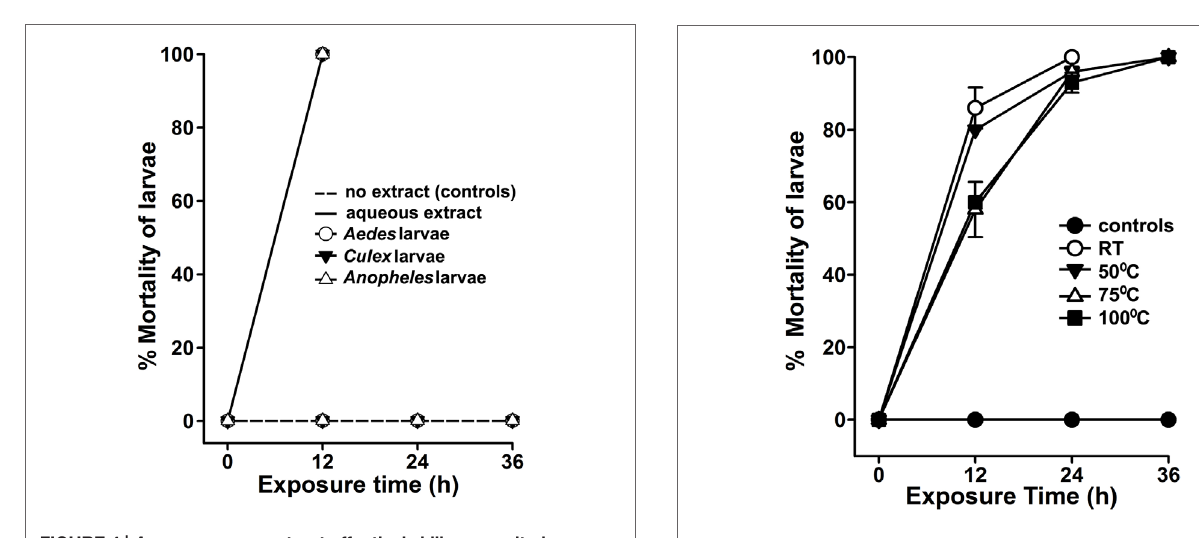
FigUre 4 | Agave aqueous extract effectively kills mosquito larvae. A. aegypti , C. quinquefasciatus, or A. stephensi larvae were sham treated (no extract, controls) or exposed to 100 μ g/ml aqueous extract of Agave angustifolia . The percentage mortality of larvae at each time point was calculated against the controls for each genus individually and represented as the mean ± SD of triplicates.